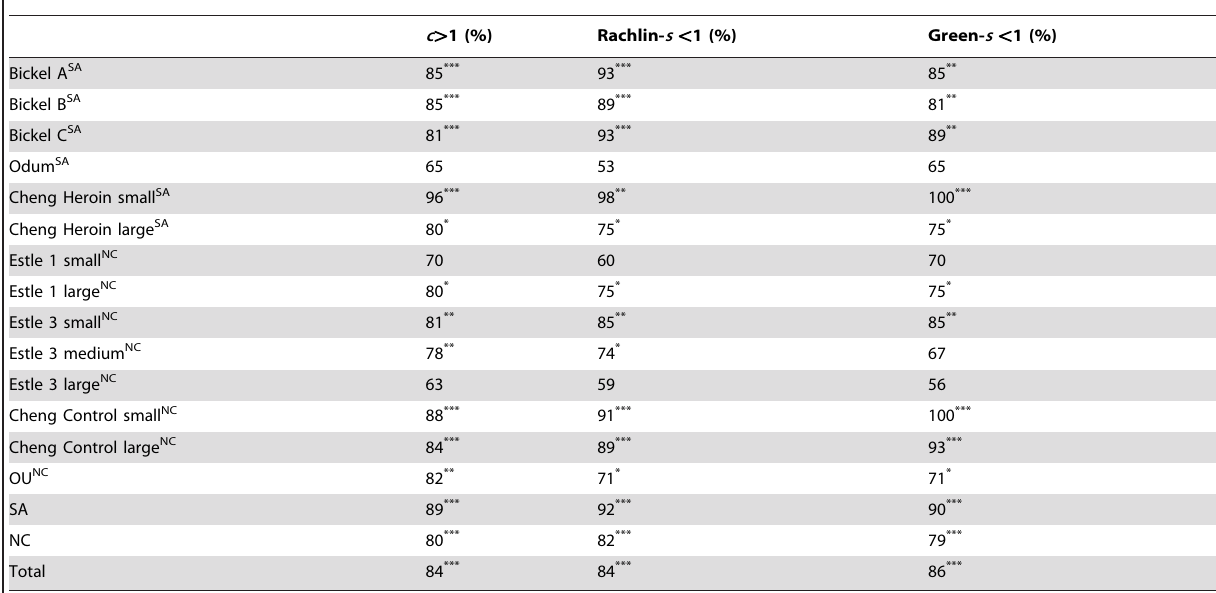
Table 7. Percentage of Deviation of Parameters From The Value of 1 in Each Study.